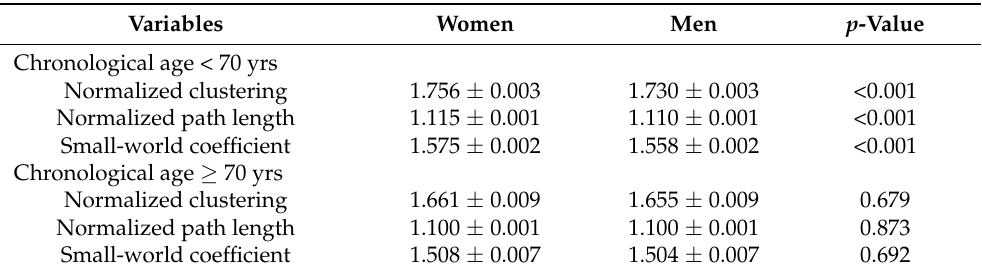
Table 3. Differences in the network properties between women and men in participants with a chronological age < 70 and ≥ 70 years.